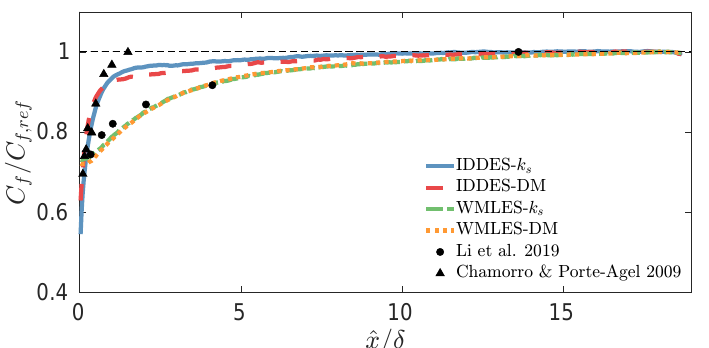
Figure 5. Normalized skin friction coefficient on the smooth strip compared with experimental results